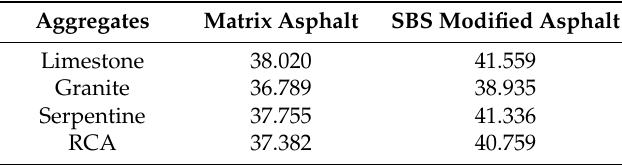
Table 9. Adhesion energy between asphalt and aggregate.